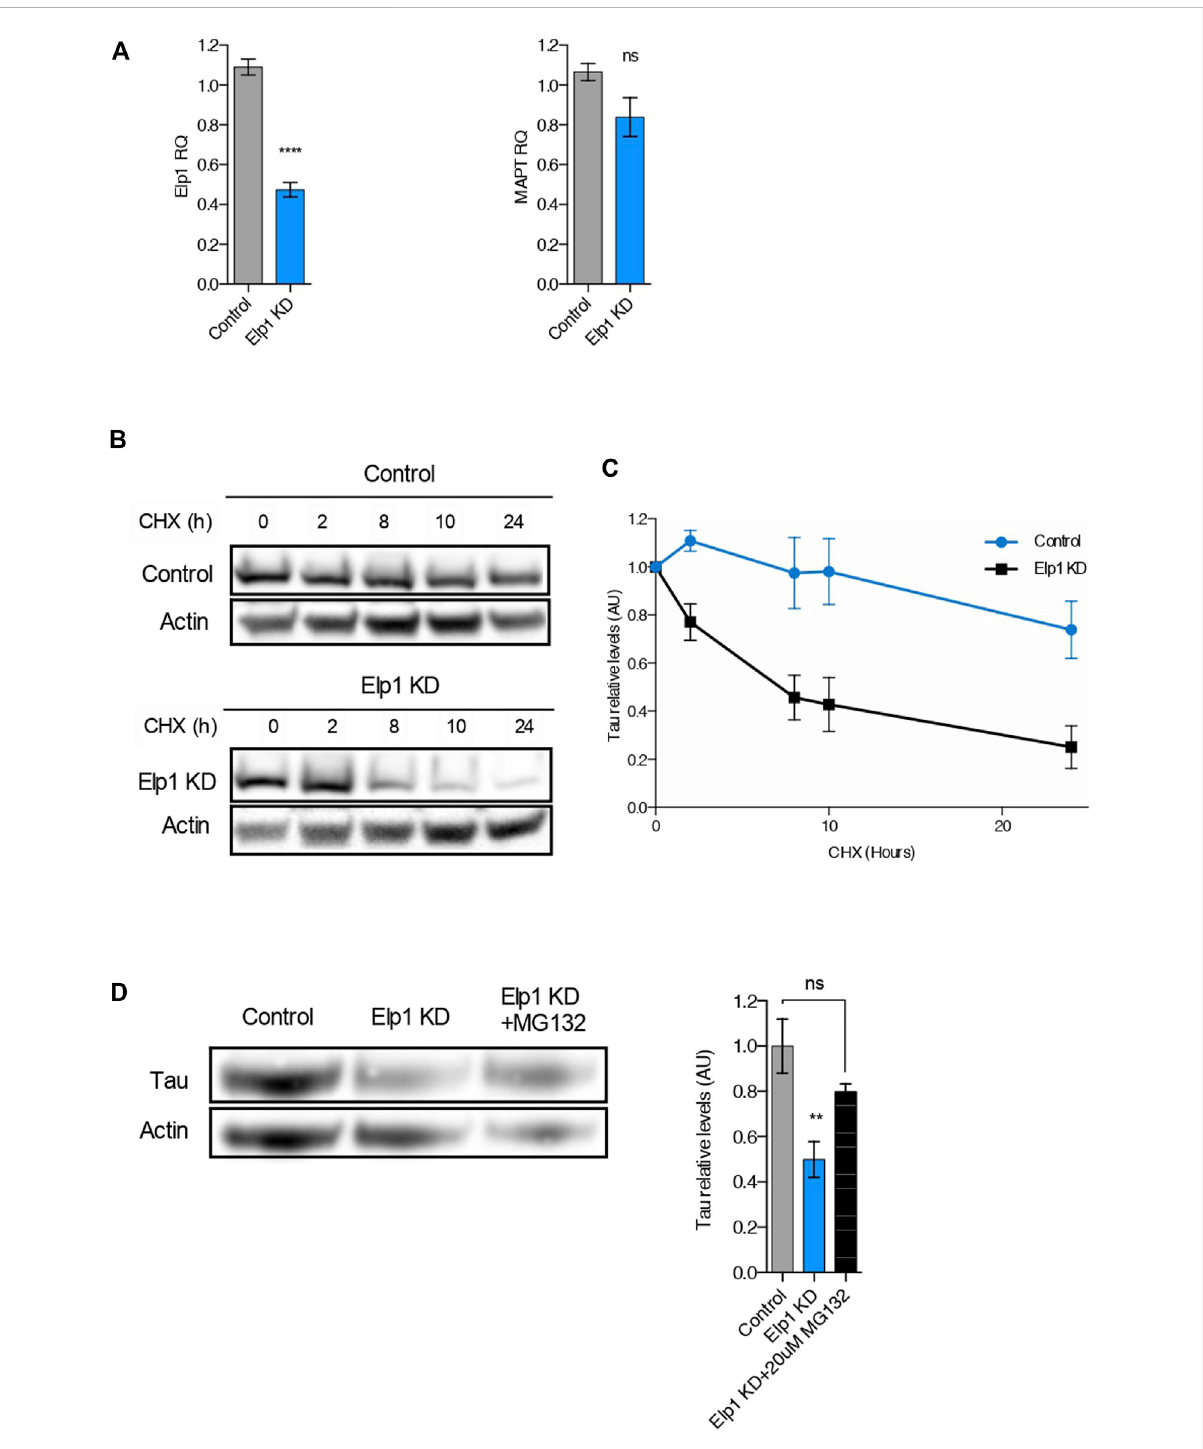
FIGURE 4 ThereductionofTaulevelsinELP1depletionisduetoTauproteininstability . (A) qRT-PCRanalysisofElp1mRNA(left)andMAPTmRNA(right)in differentiated SHSY5Y extracts from Control and Elp1 KD cells. (B,C) Immunoblotting and quanti fi cation of Tau and ß-Actin in differentiated SHSY5Y extractsfrom Controland Elp1KDcells incubated with cycloheximide (CHX, 50 μ g/ml) for0, 2, 8,10 and 24 h. (D) Immunoblotting andhistogram of Tau and ß-Actin in differentiated SHSY5Y extracts from Control and Elp1 KD cells incubated with vehicle or MG-132 (20 µM) for 4 h. All graphs showvaluesofmeans±SEM.Signi fi cancewasdeterminedby: (A) two-sided t test,Speci fi cally,[(aleft) p < 0.0001;(aright) p =0.1349;] (C) two-sided two-way ANOVA. Speci fi cally, [ p = 0.0224, F Interaction (4, 44) = 3.173] (D) two-sided one-way analysis of variance (ANOVA), Speci fi cally, [ p = 0.0084, F = 8.5; ] In addition, the post hoc multiple comparisons, to analyze statistical difference of each condition compared to control by Dunnett test,** p < 0.01. n =Numberofexperimentalrepeats: (A) Control n =5;Elp1KD n =5; (C) Control n =5;Elp1KD n =7; (D) Control n =4;Elp1KD n =5; Elp1 KD + MG132 n =